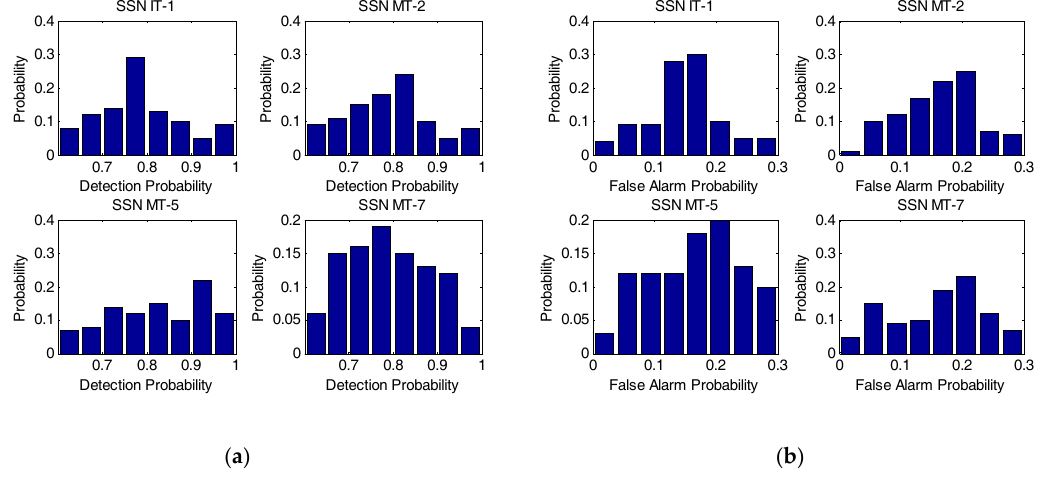
Figure 7. The detection probability and false alarm probability distributions of the selected spectrum sensor nodes involving IT-1, MT-2, MT-5, and MT-7. ( a ) Detection probability distribution; ( b ) False alarm probability distribution. IT: interior tier; MT: middle tier; SSN: spectrum sensor node.